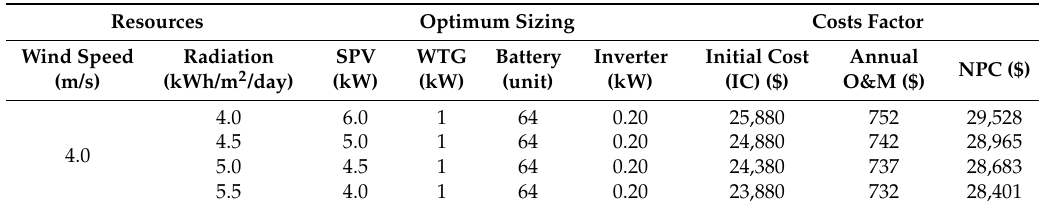
Table 3. SPV/WTG system: optimal sizing and economic